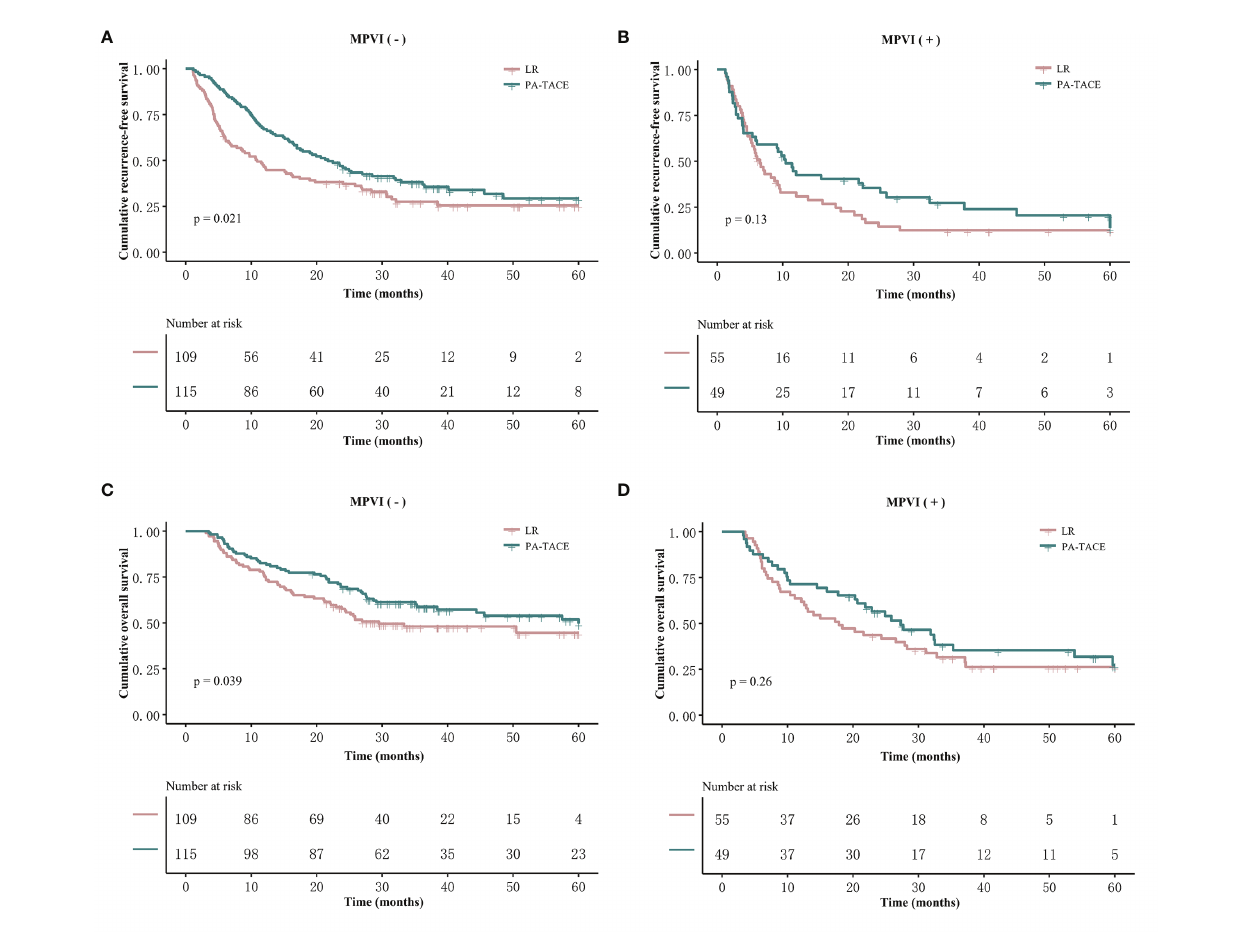
FIGURE 3 | Kaplan – Meier analysis of RFS and OS strati fi ed by treatment and the presence or absence of MPVI in the PSM cohort. Patients without MPVI who received PA-TACE had better RFS (A) and OS (C) than those who underwent liver resection alone. The RFS (B) and OS (D) of patients with MPVI showed no signi fi cant differences between the PA-TACE and LR alone